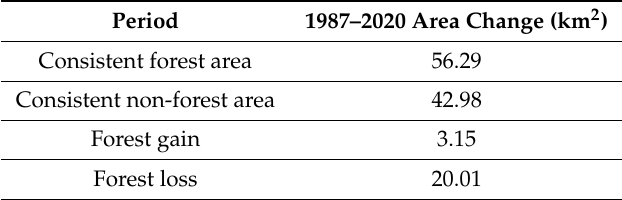
Table 6. Overall forest loss / gain in km 2 from 1987 to